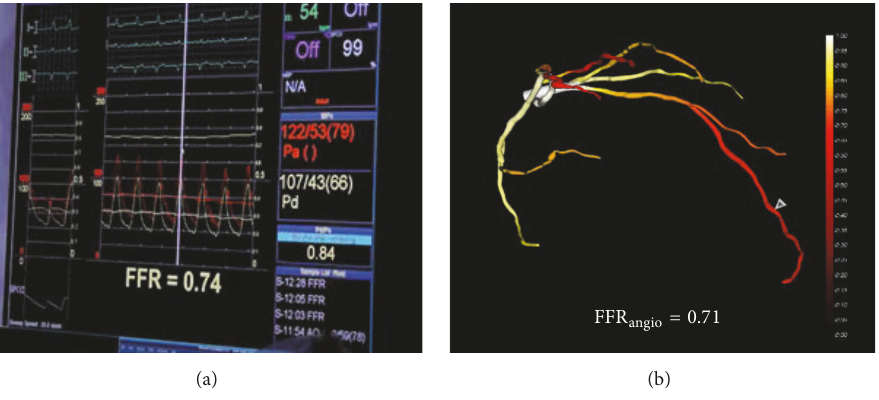
Figure 2: Posttreatment FFR (a) and FFR (b) assessments at the distal LAD segment following stenting of the middle and distal lesions. angio